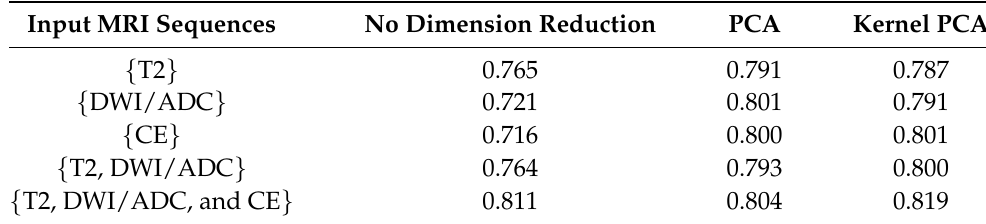
Table 2. Comparison of pCR prediction performance of five types of input MRI sequences. For a fair comparison, we extract both MSFI embedding and radiomics features from input MRI sequences, apply three different dimension reduction methods in { No dimension reduction, PCA, and Kernel PCA } and report the AUC of an ensemble